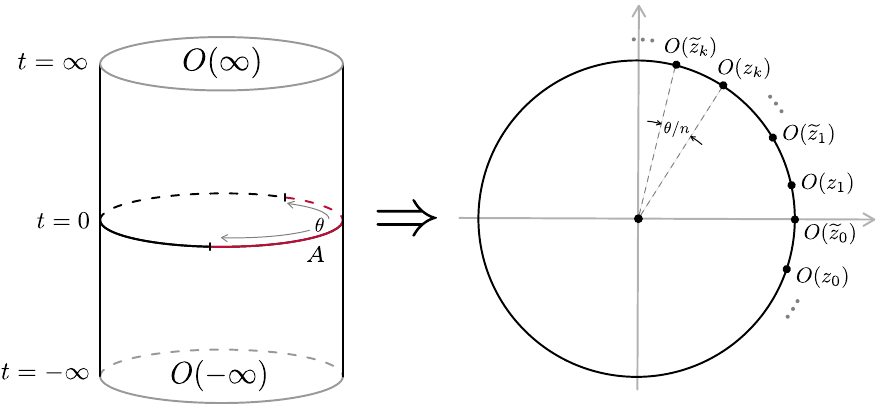
Figure 2: Geometry of our set-up. Left : The geometry before the uniformization map. The operators O are inserted at ±∞ to create | ψ 〉 and 〈 ψ | . The region A of length θ is displayed in red. Right : Clockwise arrangement of operators along the unit circle in the replicated theory after unformization and a conformal map to the plane. The z distance between the operators at z and along the unit circle is θ/ n , the interval (cid:101) k k length divided by n